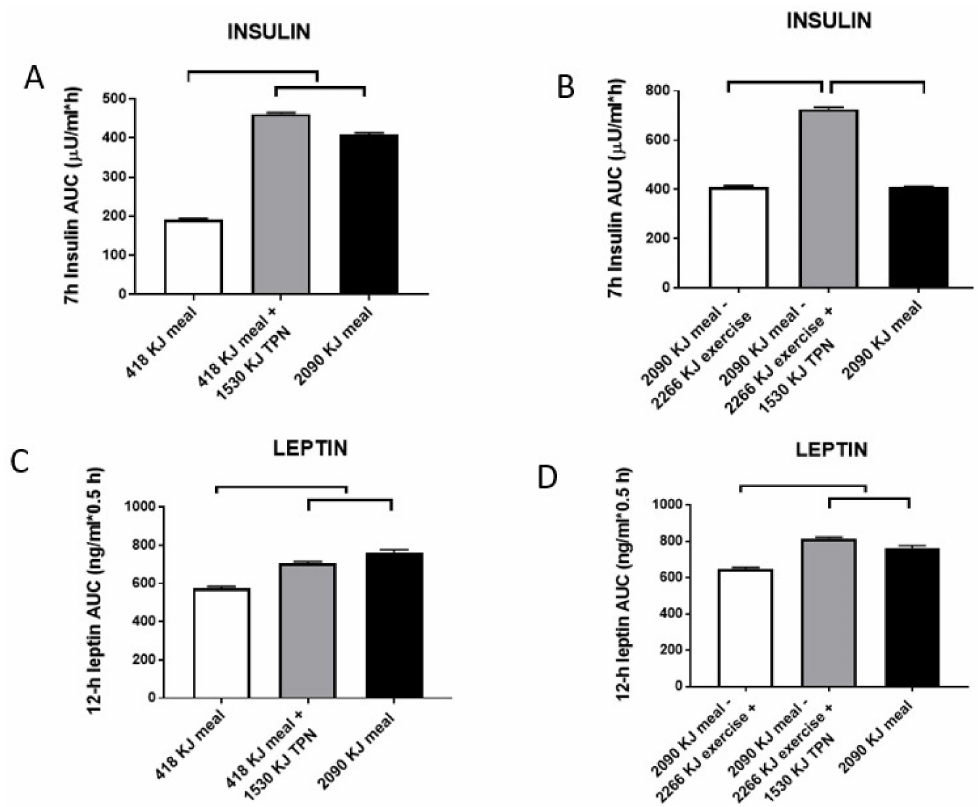
Figure 6. Post-meal responses of insulin ( A , B ) and leptin ( C , D ) to changes in morning meal size (418 vs. 2090 kJ) and 1530-kJ TPN supplementation while sedentary ( A , C ), or after 2266 kJ of exercise energy expenditure (EX) following the 2090-kJ morning meal with or without TPN supplementation ( B , D ). Post-meal insulin was highly responsive to changes in both the meal size and TPN energy, but not to exercise energy expenditure. Day-long changes in leptin responded to both differences in the energy provided by two meals and supplemental TPN infusion, and to exercise energy expenditure. Upper and parallel brackets denote significant differences ( p < 0.001). Data were modified from Reference